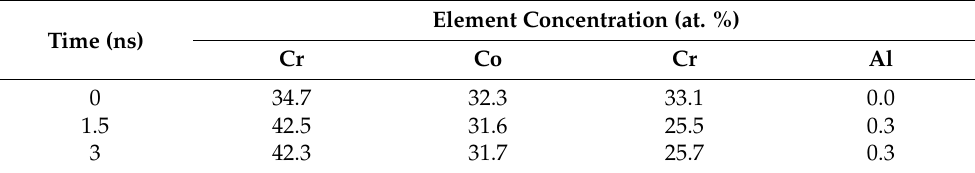
Table 3. Atomic Concentrations of Ni, Cr, Co, and Al at Grain Boundary of Medium-Entropy Alloy CrCoNiAl 0.014 at 700